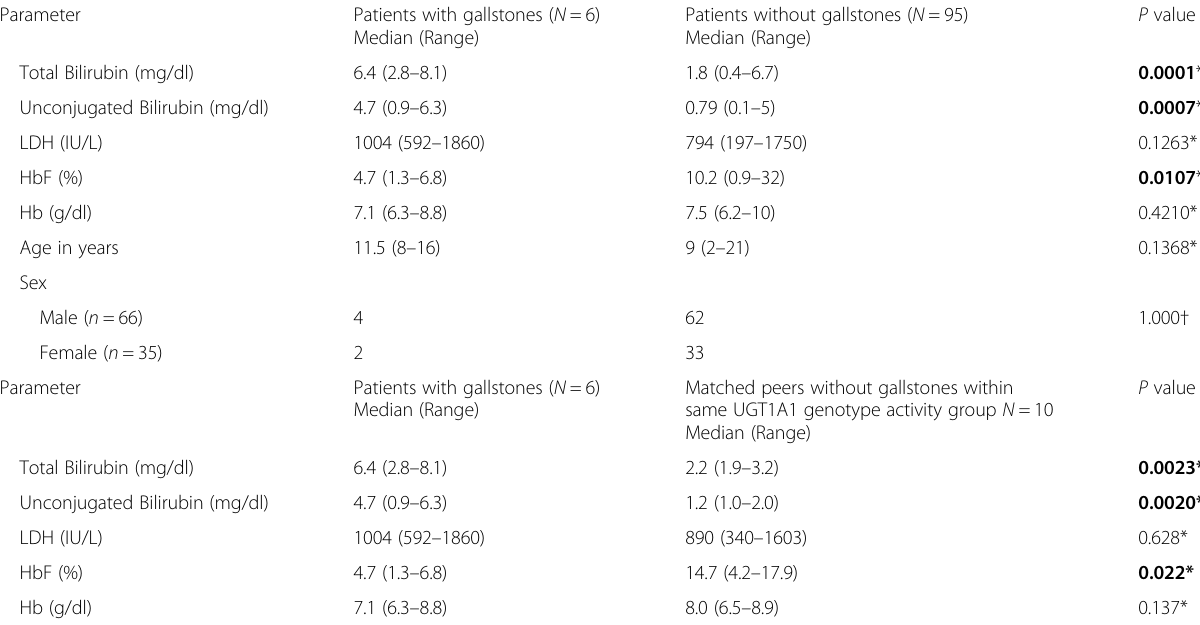
Table 4 Comparison of parameters in patients with and without gallstones Parameter Patients with gallstones ( N = 6) Patients without gallstones ( N = 95) Median (Range) Median (Range)